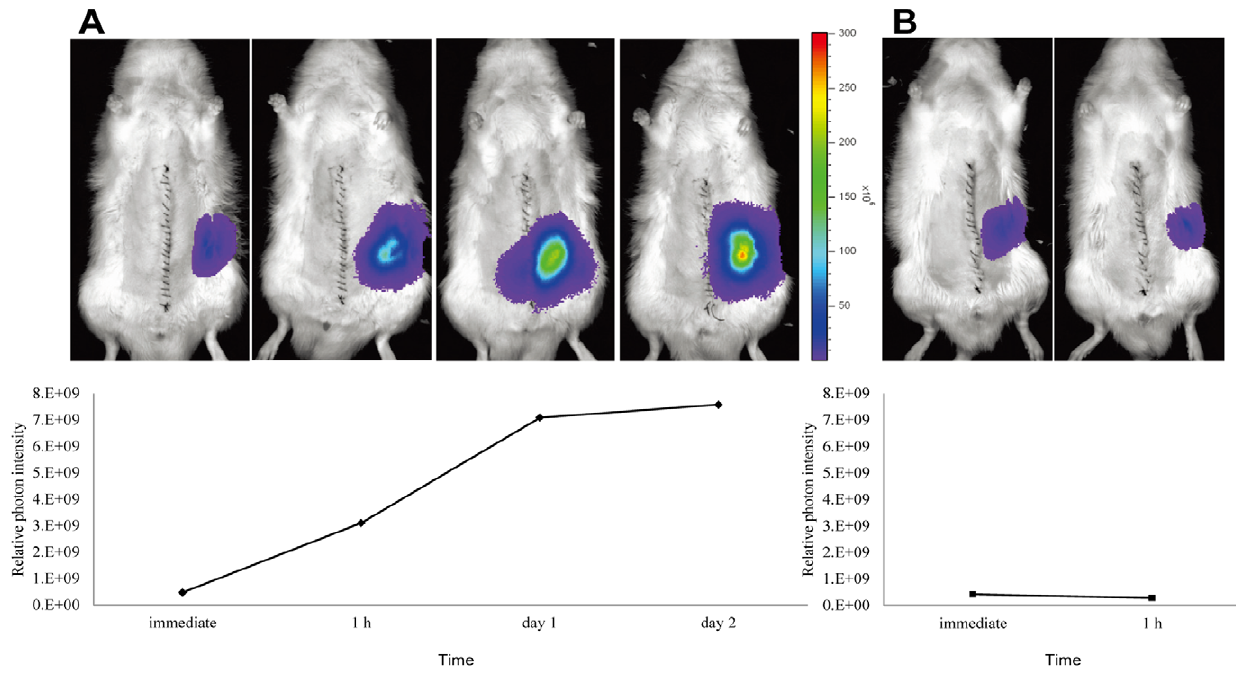
Figure 8. Comparison of change in luminescence intensity between fresh and critical kidney grafts. (A): Photon flux of rat transplanted fresh kidney began to increase at 1 h after RTx, and stabilized after 1 day. (B): Photon flux of the critical kidney was unchanged and the recipient rat did not survive.